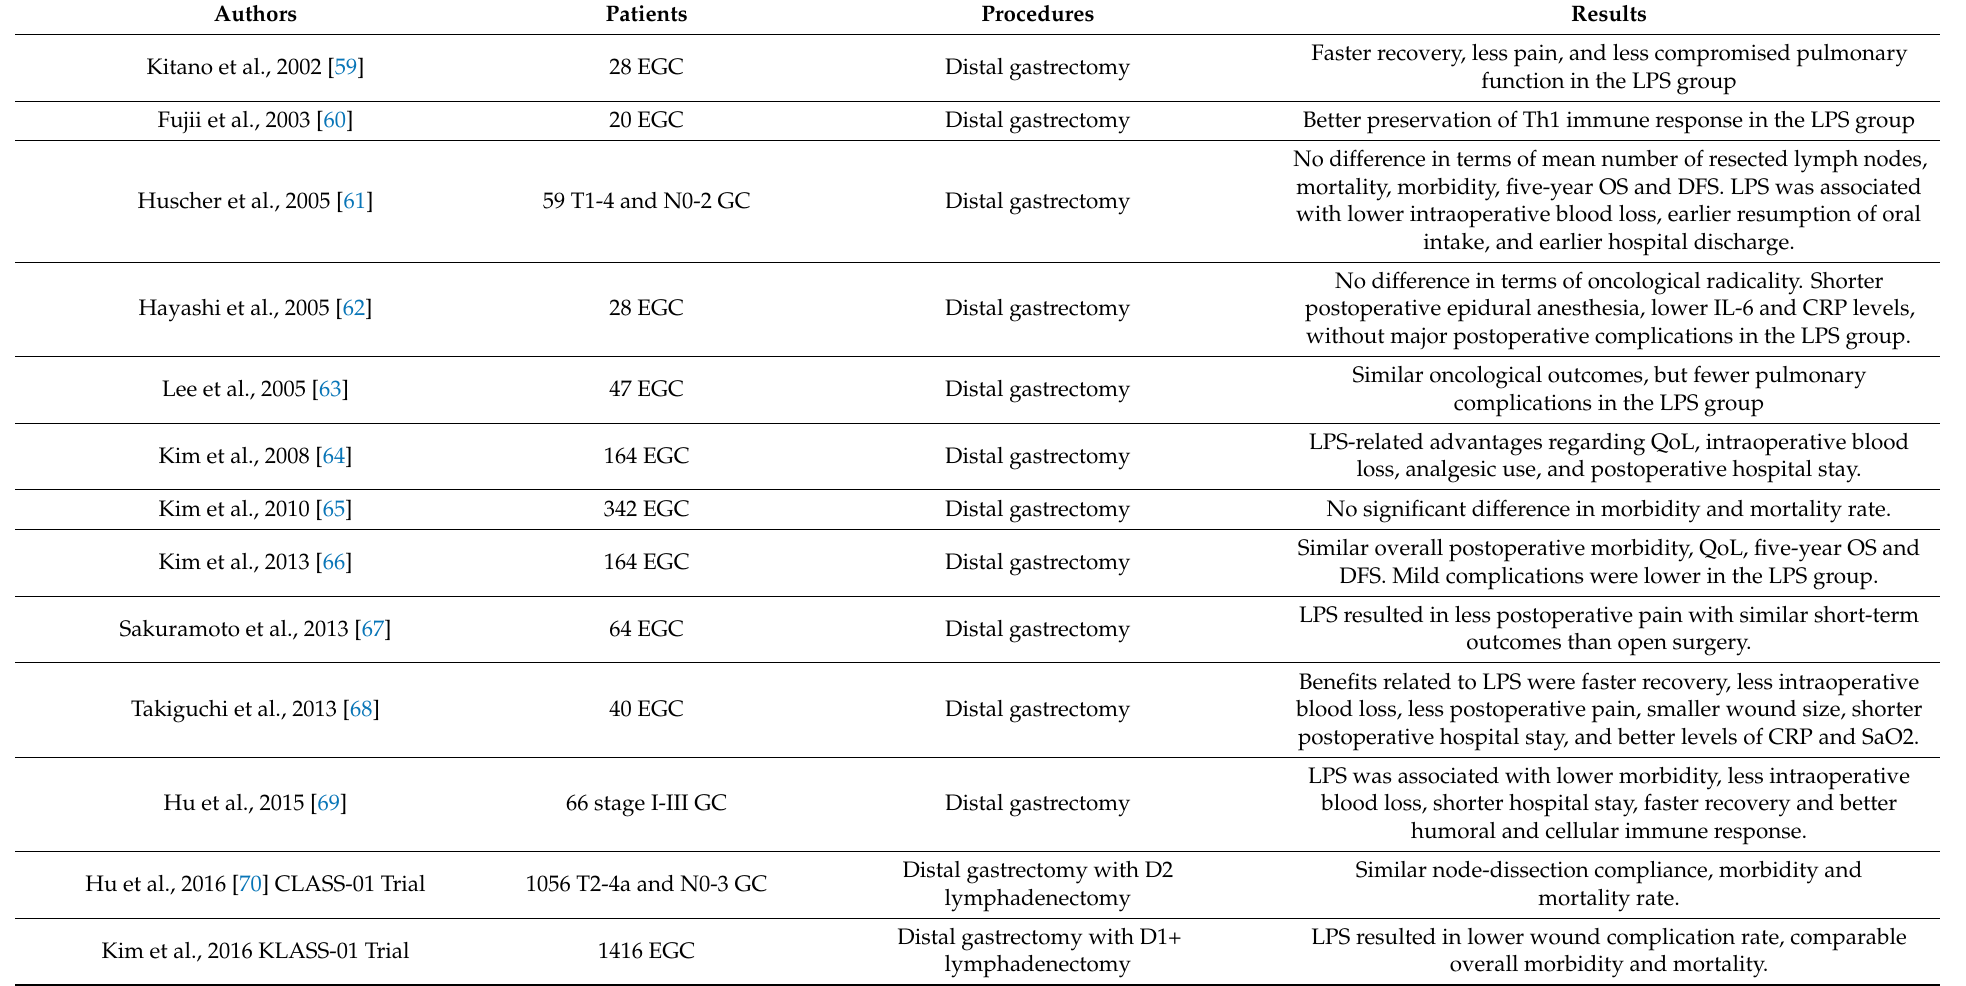
Table 3. Randomized clinical trials on laparoscopic versus open gastrectomy for gastric